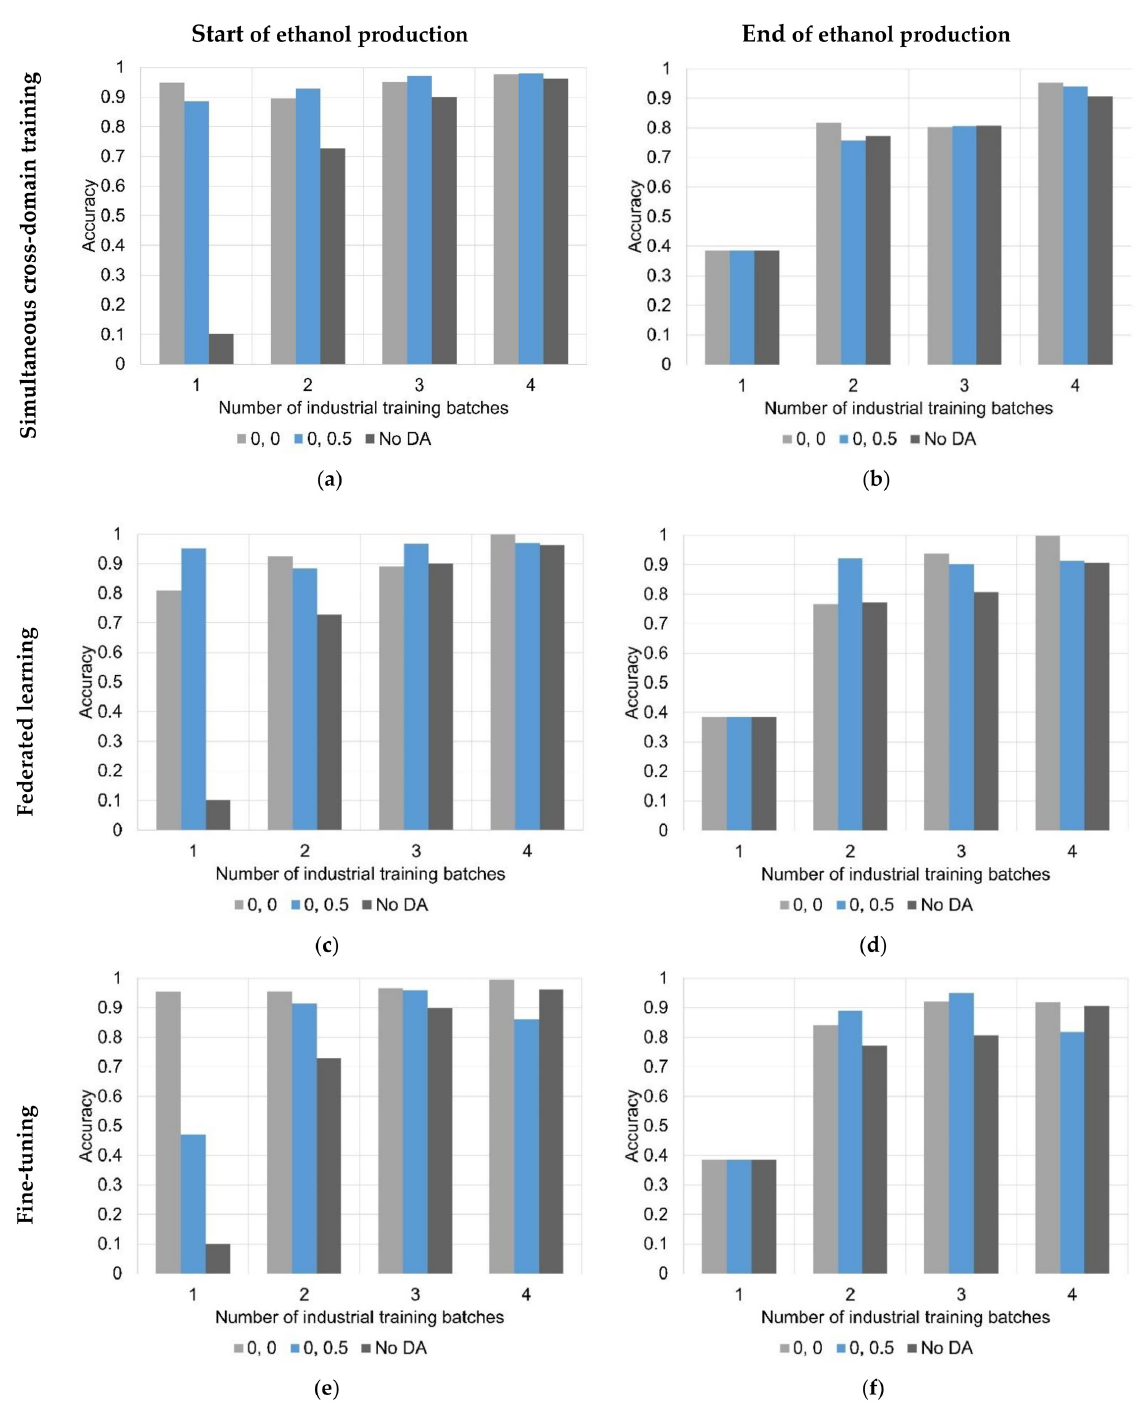
Figure 5. The classification results on the industrial scale fermentations test set. The numbers in the legend indicate the dropout layer probability for the two dropout layers. E.g., 0, 0 indicates a dropout probability of zero in both layers. ( a ) Classification results for the start of ethanol production for the networks trained on both domain datasets simultaneously. ( b ) Classification results for the end of ethanol production for the networks trained on both domain datasets simultaneously. ( c ) Classification results for the start of ethanol production for the networks trained using federated learning. ( d ) Classification results for the end of ethanol production for the networks trained using federated learning. ( e ) Classification results for the start of ethanol production for the federated training networks fine-tuned on the industrial scale dataset. ( f ) Classification results for the end of ethanol production for the federated training networks fine-tuned on the industrial scale